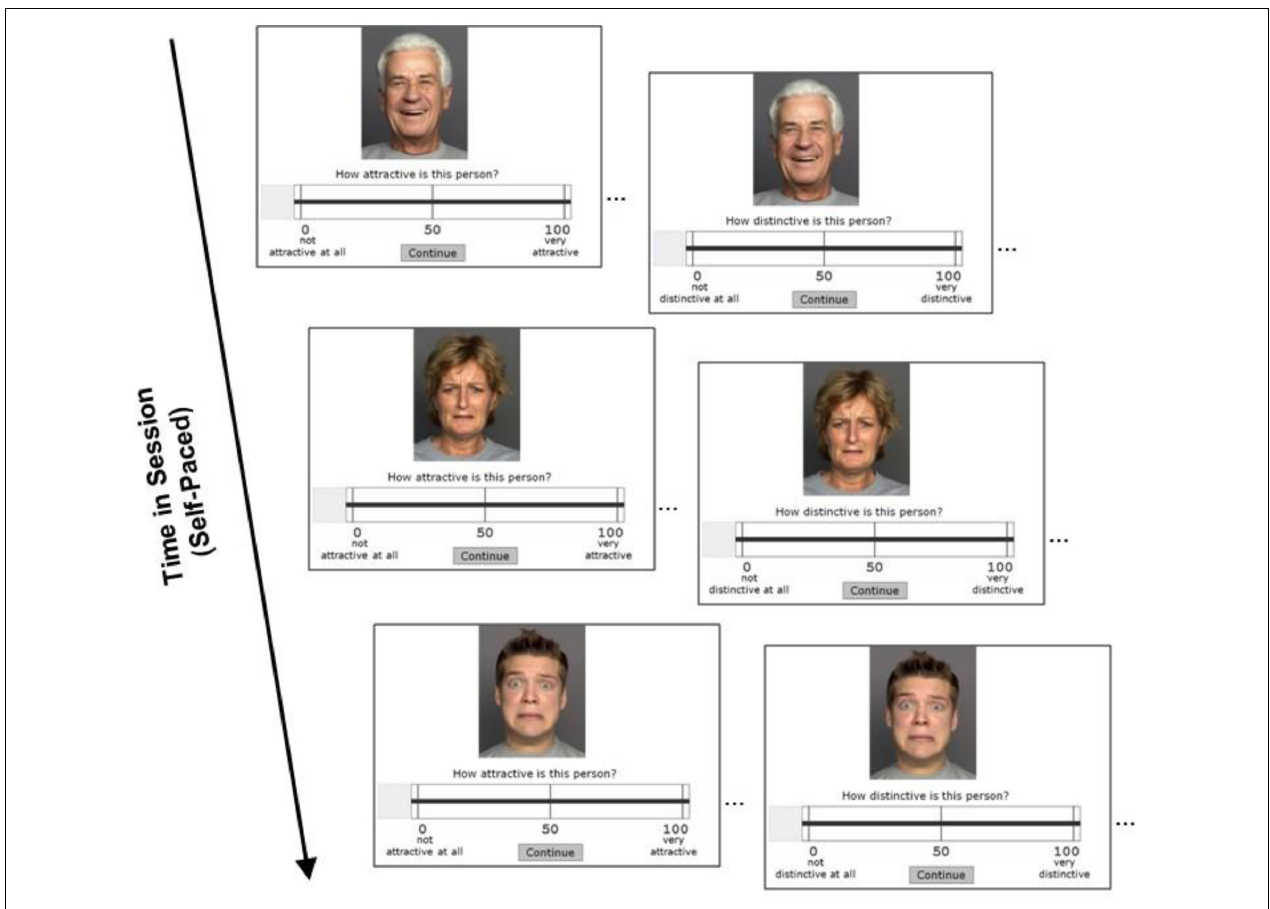
FIGURE 1 | Illustration of the rating procedure. During each session, participants rated the attractiveness and the distinctiveness of different face pictures by adjusting a slider on a scale ranging from 0 to 100. Written informed consent has been obtained from depicted individuals for the publication of the